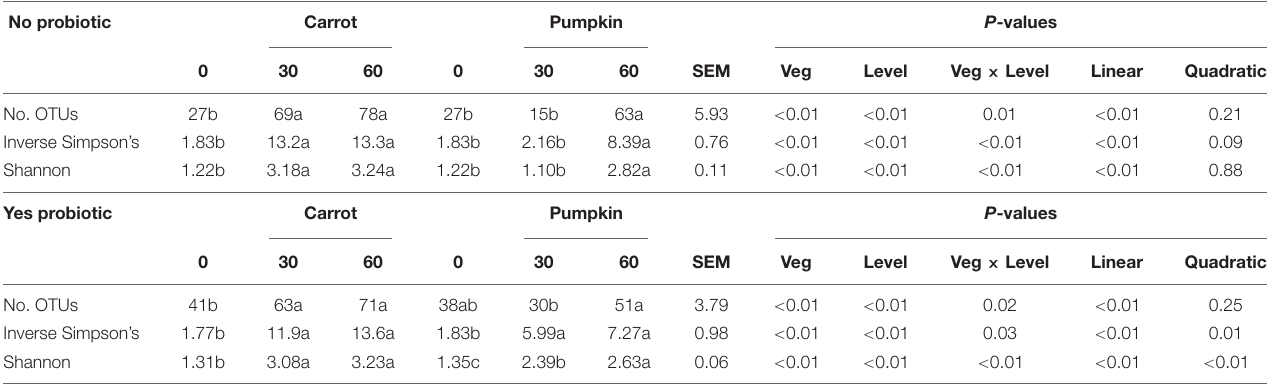
No. OTUs Inverse Simpson’s Shannon 1.31b < 0.01 < 0.01 < 0.01 < 0.01 OTUs, operational taxonomic units; SEM, standard error of the mean. Letters a and b indicate differences (P ≤ 0.05) between levels within vegetable (i.e., interaction Veg × Level was split by vegetable). Interactions of Prob, Veg × Prob, Level × Prob, and Veg × Level × Prob were significant for the Shannon’s diversity index and number of OTUs (Level × Prob; P = 0.02). TABLE 4 | Measures of alpha diversity for sorghum ensiled with carrot or pumpkin at 0, 30, or 60% DM for 70 days, separated by probiotic. No probiotic Carrot Pumpkin P -values 0 30 60 Q No. OTUs